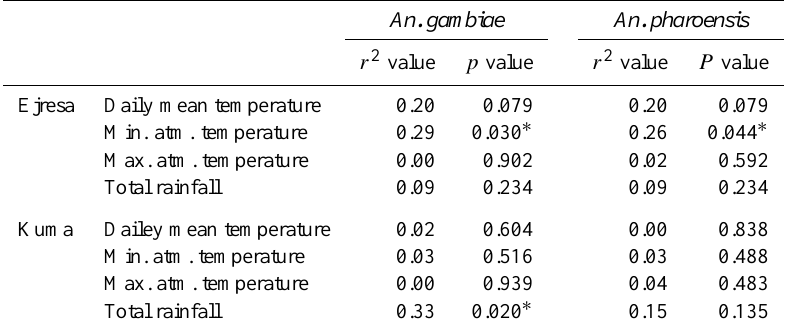
Table 4. Correlation between abundance of An. gambiae s.l. and An. pharoensis with daily mean atmospheric temperature ( ◦ C), atmospheric minimum and maximum temperature ( ◦ C) and total rainfall (mm) at Ejersa and